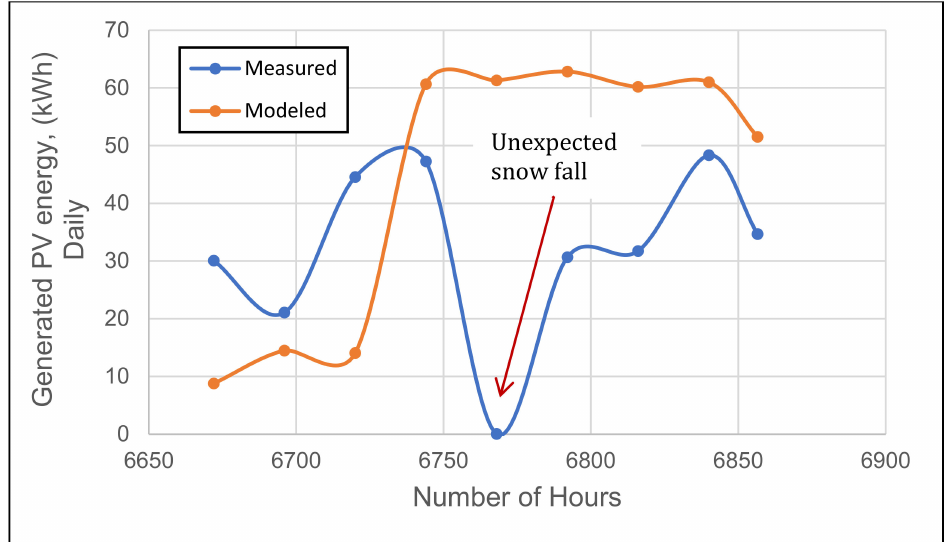
Figure 12. The daily generated energy by the PV panel system compared to the model